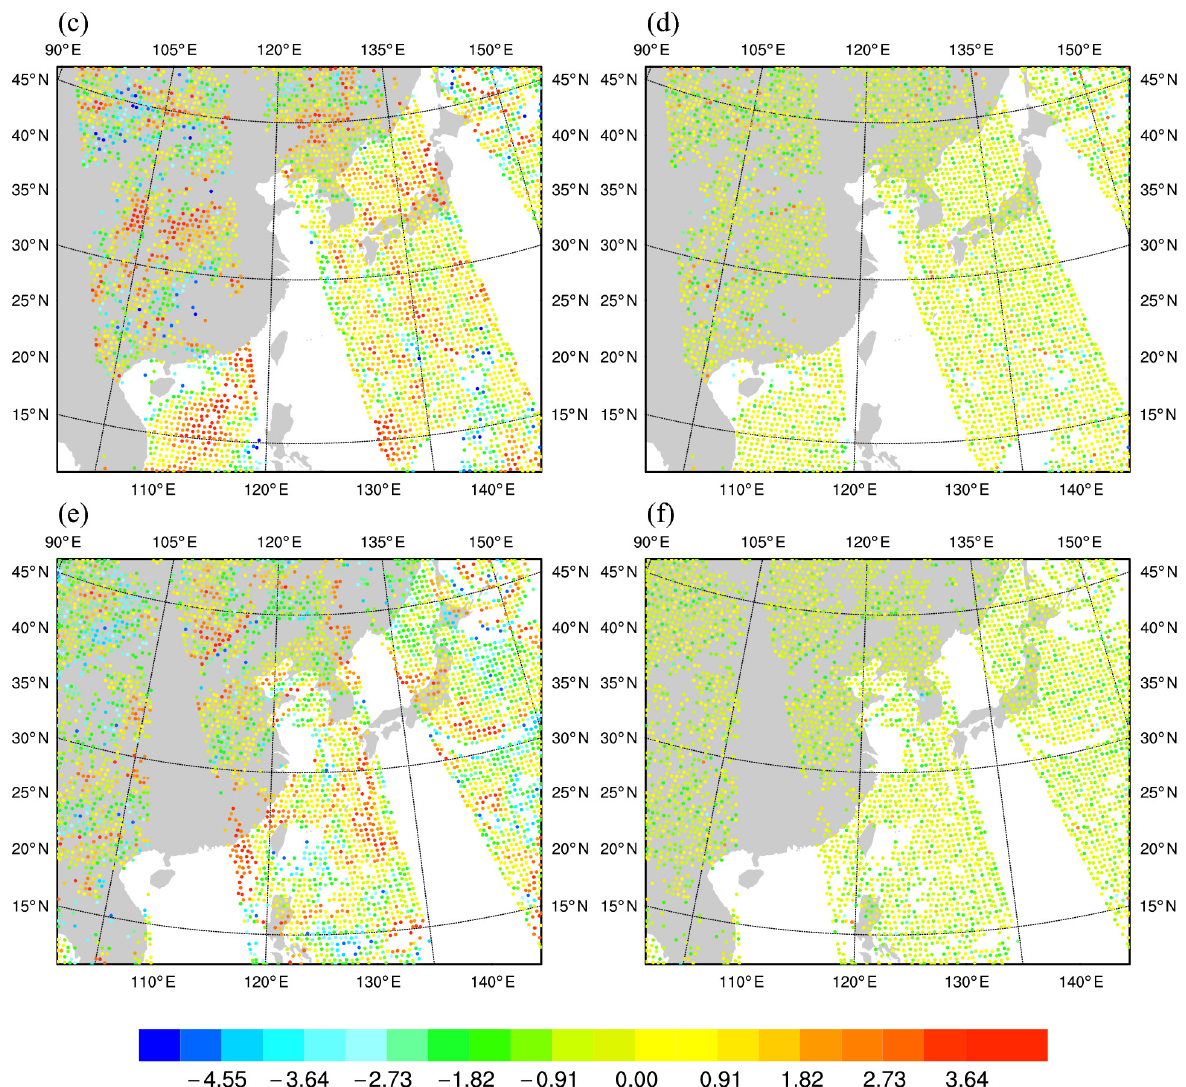
Figure 2. ( a , c , e ) OMB and ( b , d , f ) OMA after bias correction at 0600UTC on 22 July 2018, with NOAA-19 AMSUA channel 5 in the upper row, NOAA-19 MHS channel 4 in the middle row, and FY-3D MWHS2 channel 11 in the lower row.